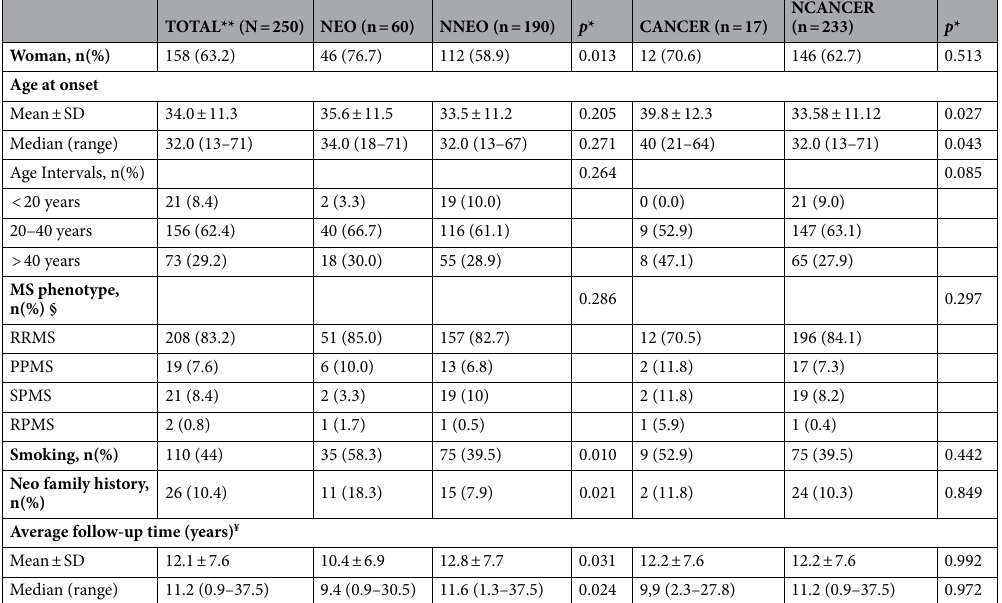
Tumour lineage. Table 2 indicates tumour frequency, site, developmental lineage, and cell line. Sixty